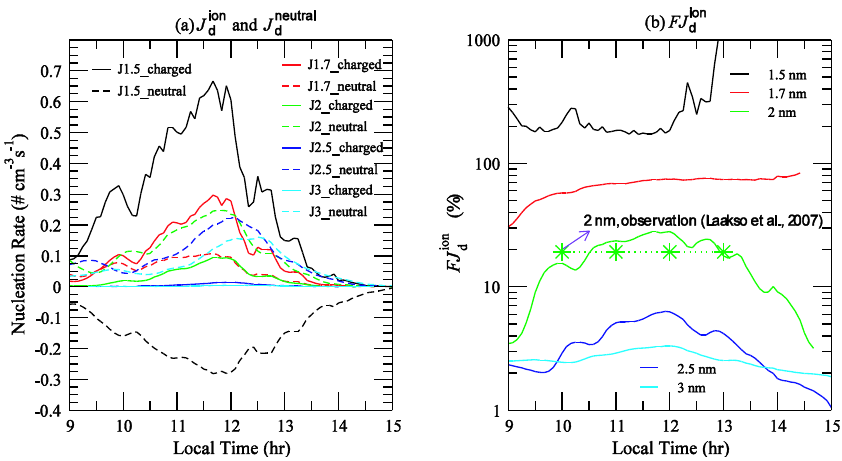
0 ) and (b) the corresponding or J neutral , and J ion d d d